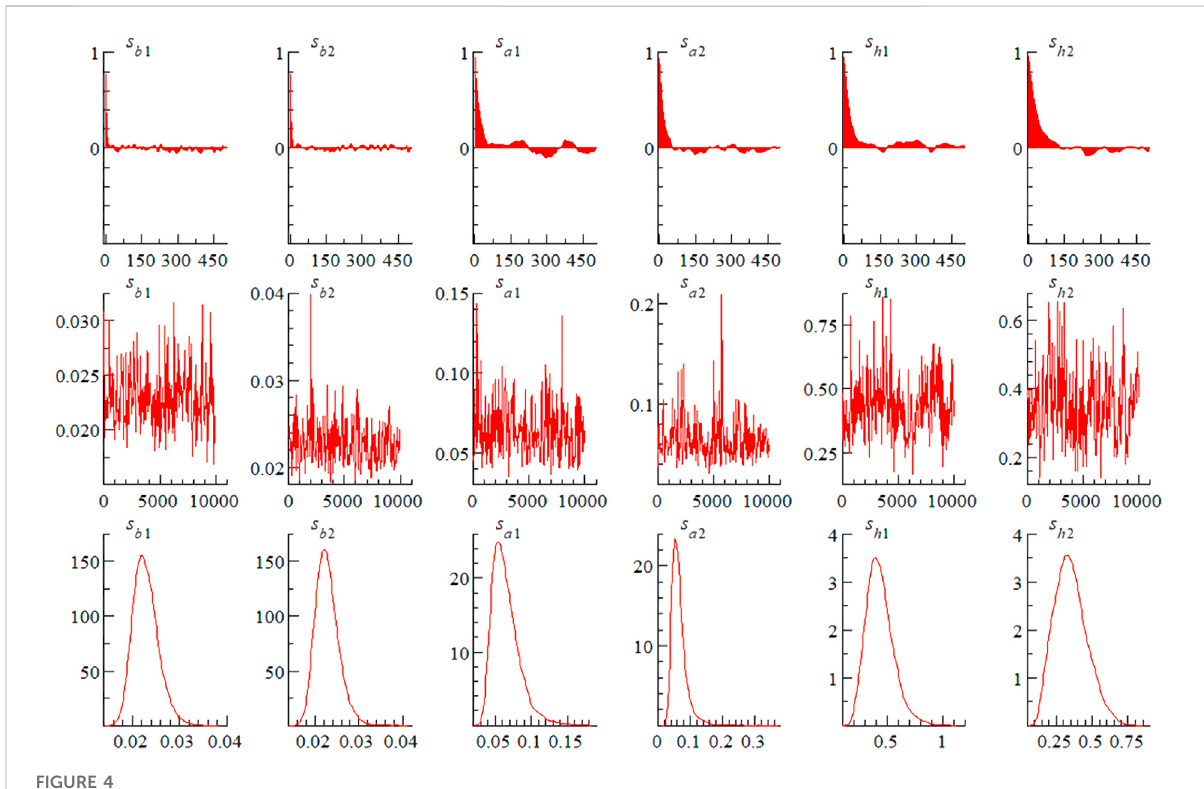
FIGURE 4 MCMC parameter estimation